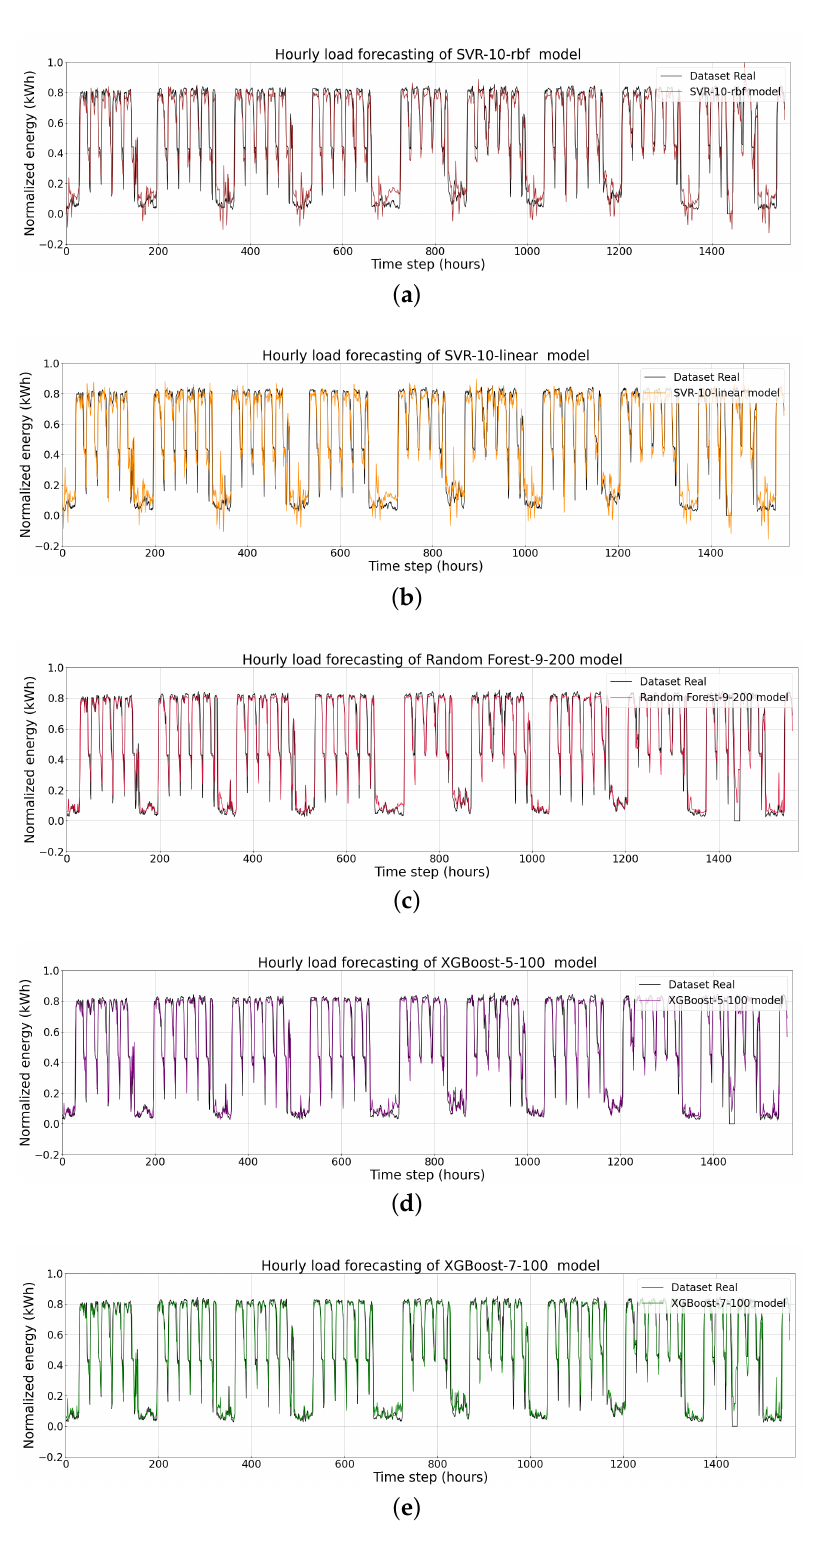
Figure 13. Hourly load forecasting using ( a ) the SVR-10-rbf model; ( b ) the SVR-10-linear model; ( c ) the Random Forest-9-200 model; ( d ) the XGBoost-5-100 model; and ( e ) the XGBoost-7-100